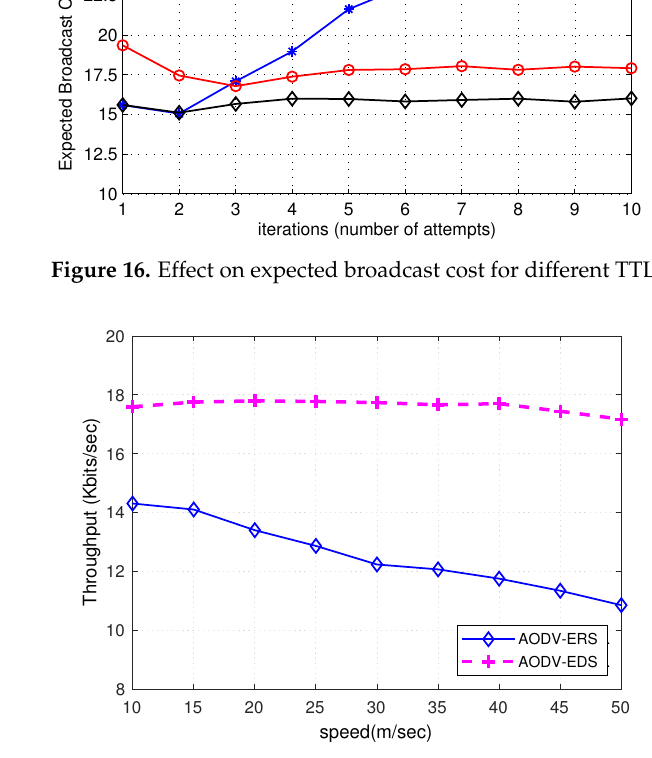
Figure 17. Throughput Comparison of ERS and EDS.